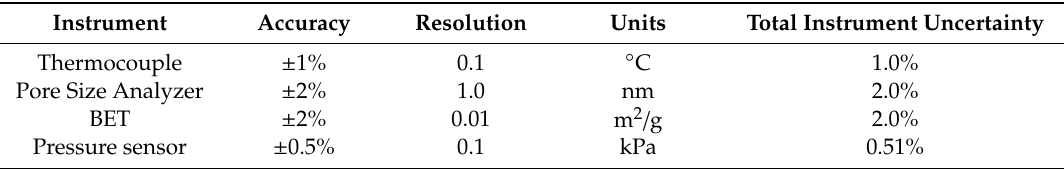
Table 4. Instrument